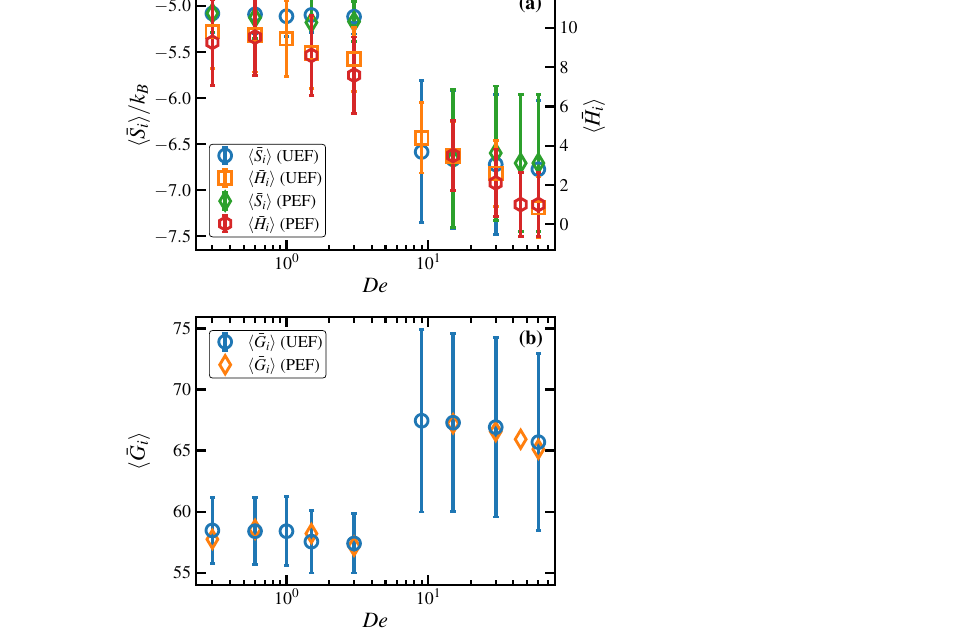
Figure 12. The ensemble-average local atomic entropy, enthalpy (panel ( a )), and Gibbs free energy (panel ( b )) as functions of De for the UEF and PEF simulations of the C 1000 H 2002 melt in (dimension- less) reduced LJ units. Note the high degree of agreement between UEF and PEF data, in spite of the large error bars on some of the